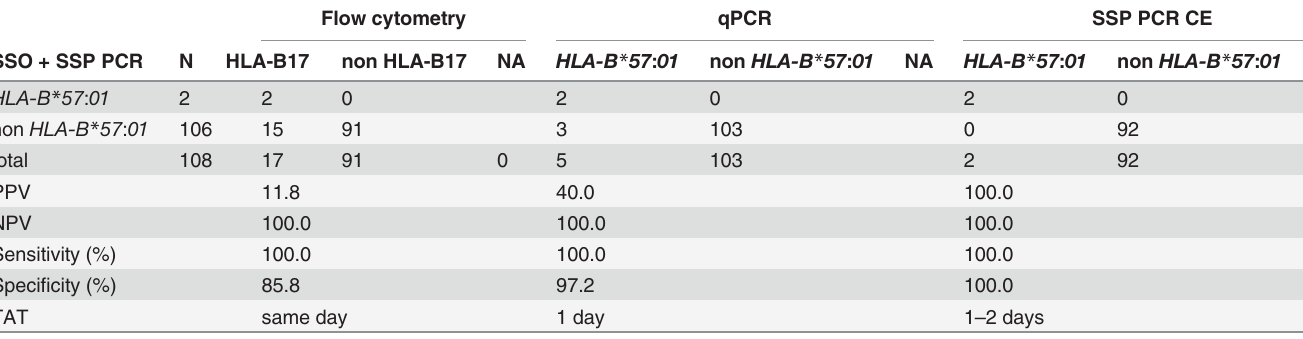
Flow Cytometry. Flow cytometry screening was performed on 108 prospectively collected samples with unknown HLA-B (cid:1) 57 : 01 status. This resulted in positive flow cytometry results for 17 samples (16%) of which only 2 patients were determined as HLA-B (cid:1) 57 : 01 positive by SSO (S4 Table). Of the 91 samples that were negative by flow cytometry, all samples were confirmed negative by SSO. Within the 17 HLA-B17 positive samples, a comparison of the MFI of all HLA-B (cid:1) 57 : 01 positive samples versus HLA-B (cid:1) 57 : 01 negative revealed that the latter had a sig- nificantly lower MFI (p < 0.0001 by Wilcoxon rank sum test) (S2 Fig). Assessment of the HLA alleles that resulted in positive flow cytometry signals with the HLA-B17 antibody was subse- quently performed by high resolution SSP PCR (Table 3 and S4 Table). This revealed that only 3 samples with the HLA-B (cid:1) 57 : 03 allotype and 2 samples with the HLA-B (cid:1) 58 allotype resulted in fluorescent signals that were indiscernible from the fluorescent signals of HLA-B (cid:1) 57 : 01 posi- tive samples (S4 Table). Based on this data, the samples were re-assessed using a less stringent cut-off at an MFI of 5000. With the original cut-off at an MFI of 500, flow cytometry reached a sensitivity of > 99%, a specificity of 85.8%, a positive predictive value (PPV) of 11.8% and a negative predictive value (NPV) of > 99%. A re-analysis of the samples using the new, less stringent cut-off at an MFI of 5000 increased the PPV of 11.8% (using the initial cut-off at an MFI of 500) to 28.6% and maintained the NPV at > 99%. qPCR. QPCR was performed on 108 prospectively collected samples. Analysis of the sam- ples with unknown HLA-B (cid:1) 57 : 01 status revealed that the two HLA-B (cid:1) 57 : 01 positive samples were detected by qPCR. In addition to these, three false positive samples were detected by qPCR compared to SSO. High resolution PCR SSP revealed that these samples all contained Table 3. Characteristics of the tested methods on the prospective samples. Flow cytometry